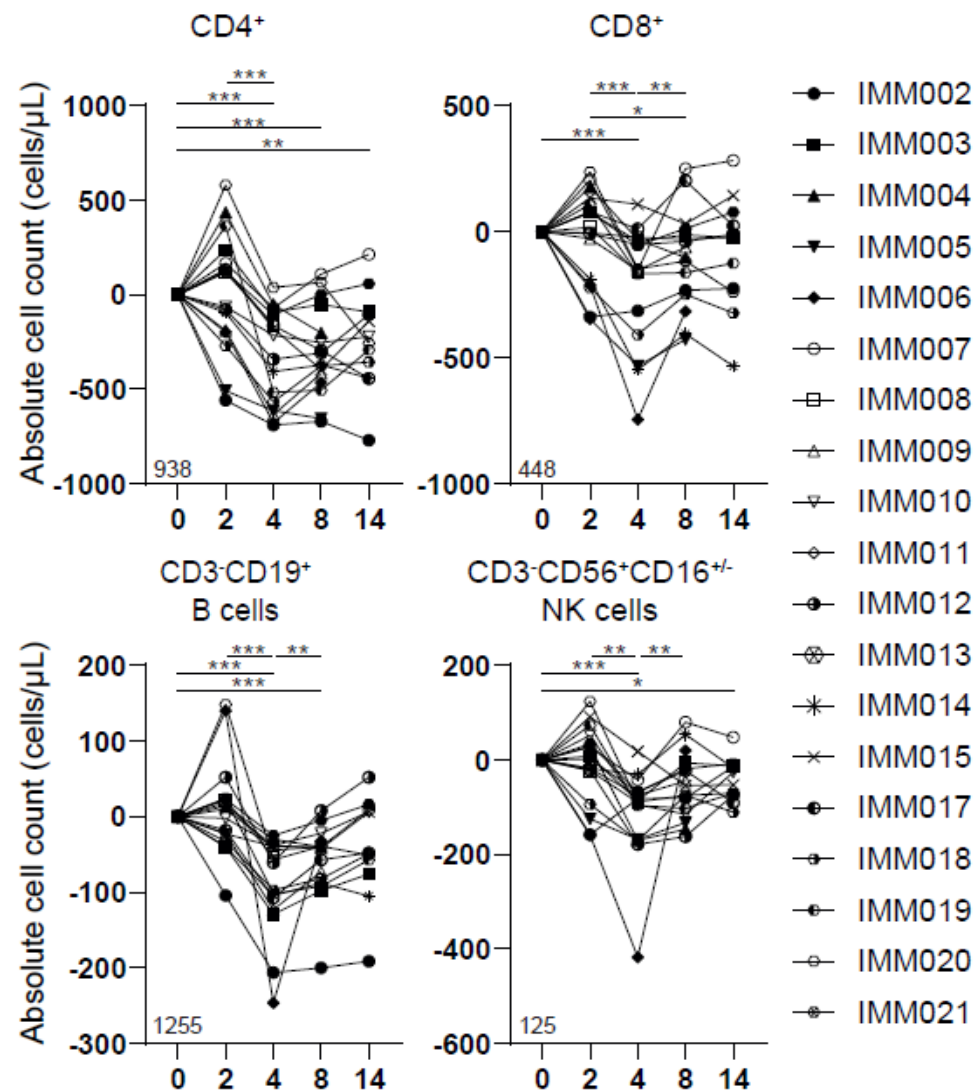
Figure 3. SBRT/IMM-101 induced transient lymphodepletion. Number of CD4+, CD8+, CD3 − CD19+ and CD3 − CD56+CD16+/ − peripheral blood lymphocytes per µL blood. N = 19. Data were normalized for baseline (week 0) and paired per patient. Percentage in the bottom left corner is the average frequency at baseline. Significance was determined using the paired Wilcoxon signed-rank test. * p < 0.05, ** p < 0.01, *** p <